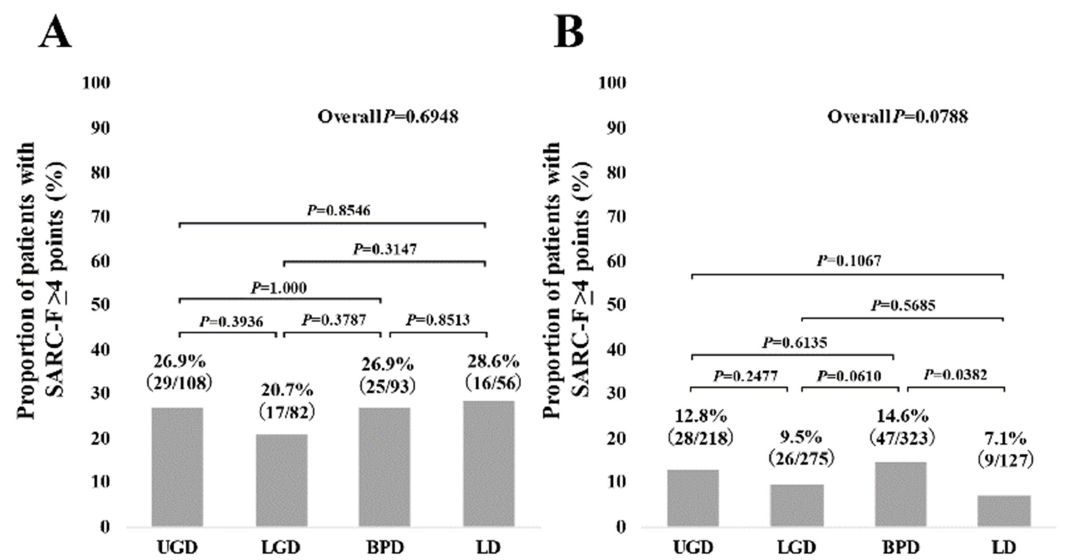
Figure 5. ( A ) The proportions of patients with SARC-F ≥ 4 points according to the diseases (UGD, LGD, BPD, and LD) in patients with advanced cancer ( n = 339). ( B ) The proportion of patients with SARC-F ≥ 4 points according to the diseases (UGD, LGD, BPD, and LD) in patients without advanced cancer ( n = 943).